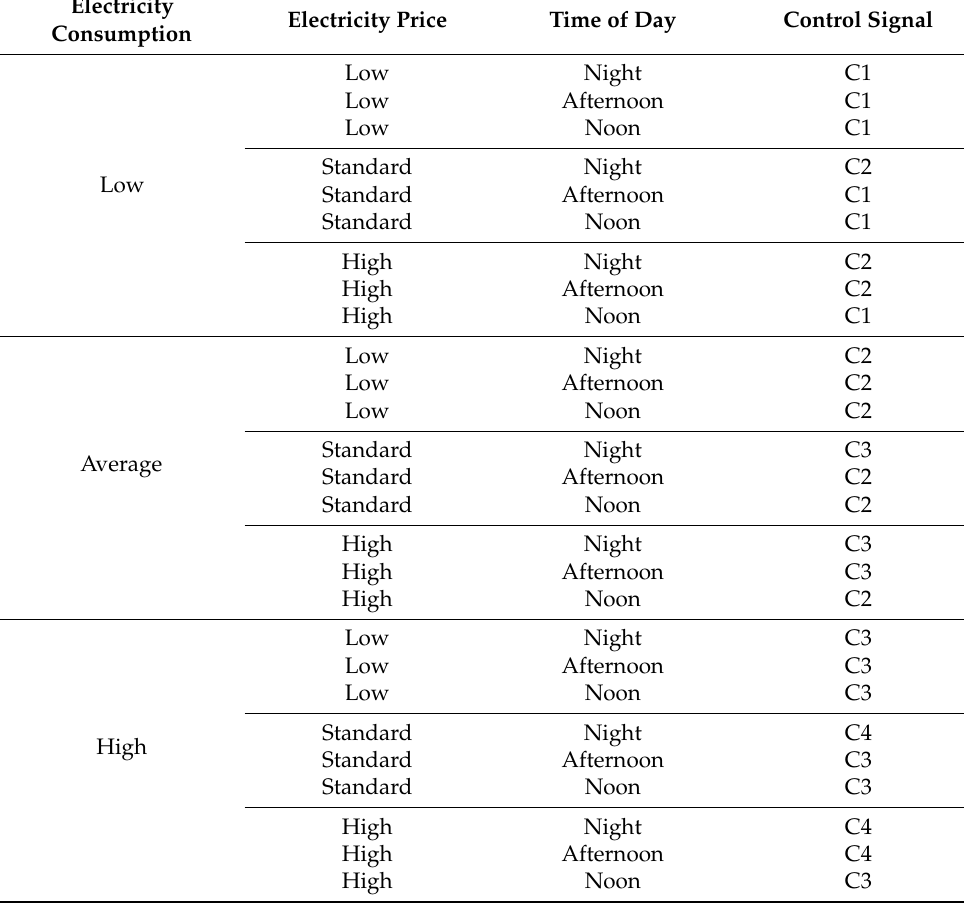
Table 1. Fuzzy rules used in this